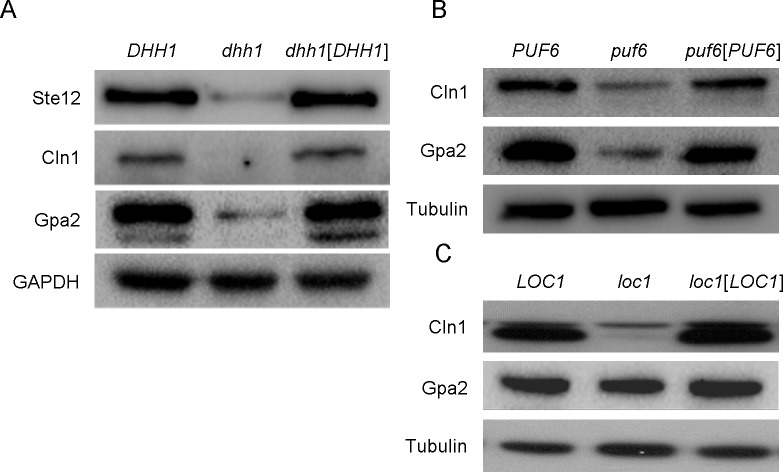
Effects of dhh1, loc1, and puf6 mutations on the protein expression levels of Cln1 and Gpa2.(A) Western blots of Ste12-HA, Cln1-HA and Gpa2-HA proteins in the dhh1 mutant strain. GAPDH was detected as a loading control. (B) Western blots of Cln1-HA and Gpa2-HA proteins in the puf6 mutant strain. Tubulin was detected as a loading control. (C) Western blots of Cln1-HA and Gpa2-HA proteins in the loc1 mutant strain. Tubulin was detected as a loading control.